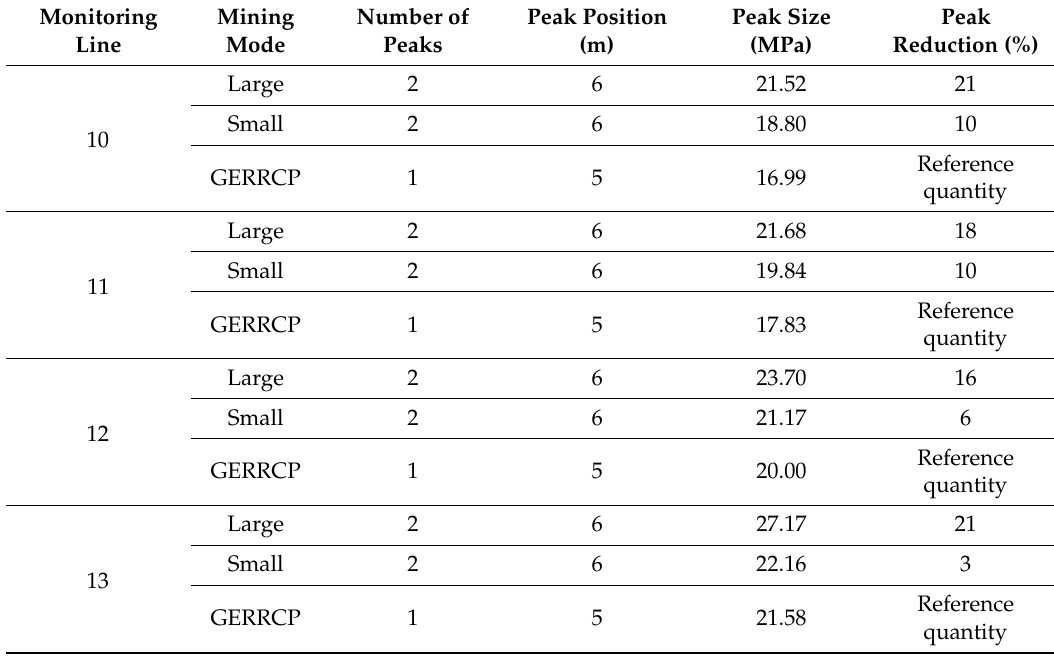
Table 6. Key parameters of the stress distribution characteristics in the left rear of the working